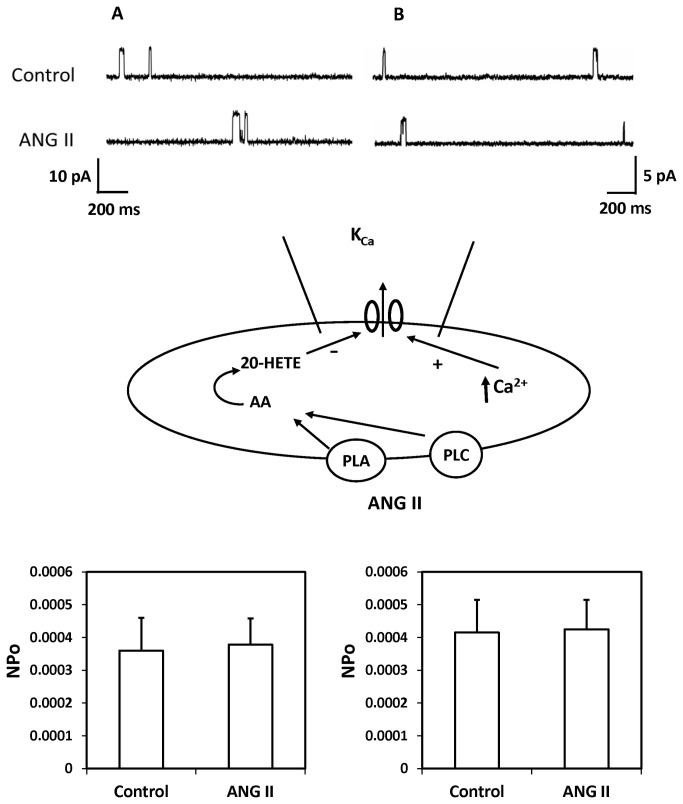
Effect of ANG II on the KCa channel activity in renal VSM cells.The upper panel presents a representative current recording of the effects of ANG II on of the KCa channel activity recorded using a cell-attached patches of VSM cells freshly isolated from renal microvessels at a pipette potential -40 mV in high K+ solution with 140 mM KCl in the pipette to null membrane potential (panel A) or in normal PSS with 140 mM KCL in the pipette at the resting membrane potential (pipette potential = 0 mV, panel B). The middle panel summarizes the cell-attached patch clamp recording mode. The lower panel presents a summary of the effects of ANG II on the activity of KCa channel recorded in depolarized cells (panel A) in a high K+ solution and in cells bathed in PSS at a normal depolarized membrane potential (panel B). Recordings were obtained from 6-8 cells under each condition.